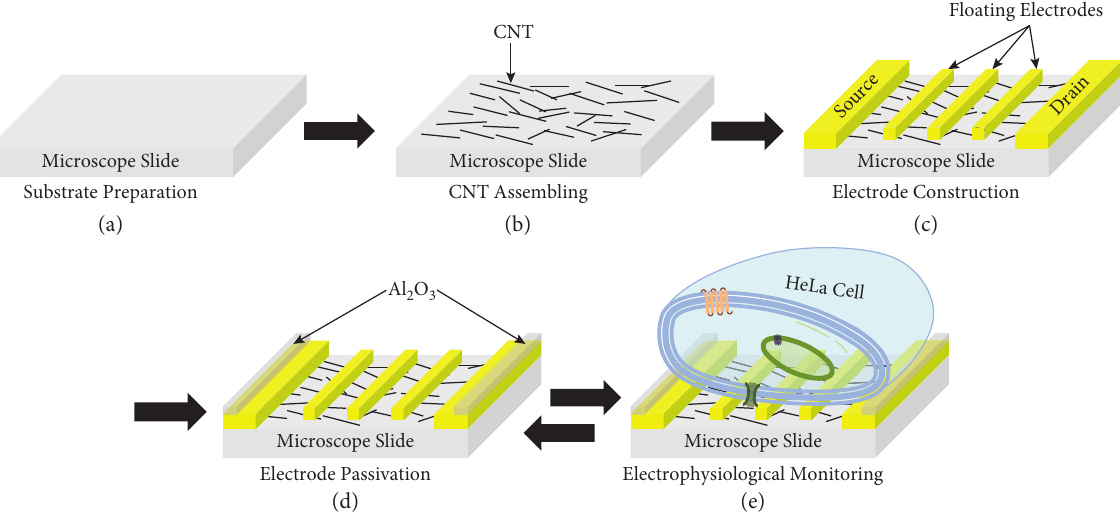
Figure 1: Schematic diagram sketching the fabrication procedures of a SCN device and the electrophysiological monitoring of a single HeLa cell using the device. (a) Preparation of a clean microscope slide. (b) Assembling of aligned ssCNTs on the clean slide. (c) Construction of the source, drain, and floating electrodes on the CNTnetwork. (d) Passivation of the source and drain electrodes by an Al 2 O 3 layer. (e) Loading and monitoring of a HeLa cell on the SCN device. The drawing is not to